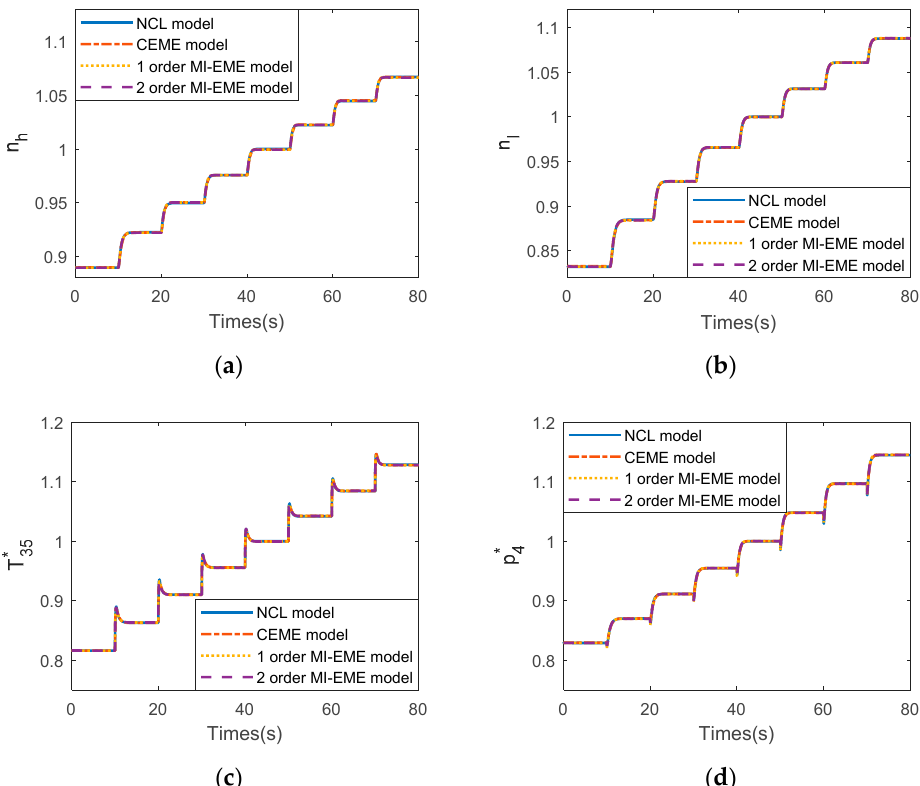
variations in training 35